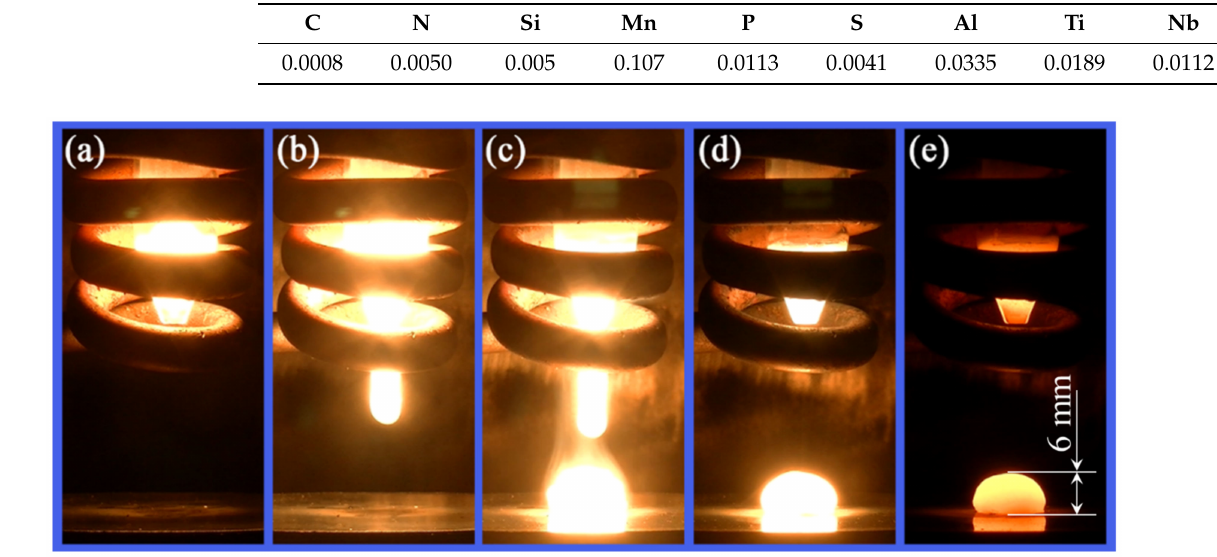
Table 1. Chemical composition of the studied IF steel (Weight percent).